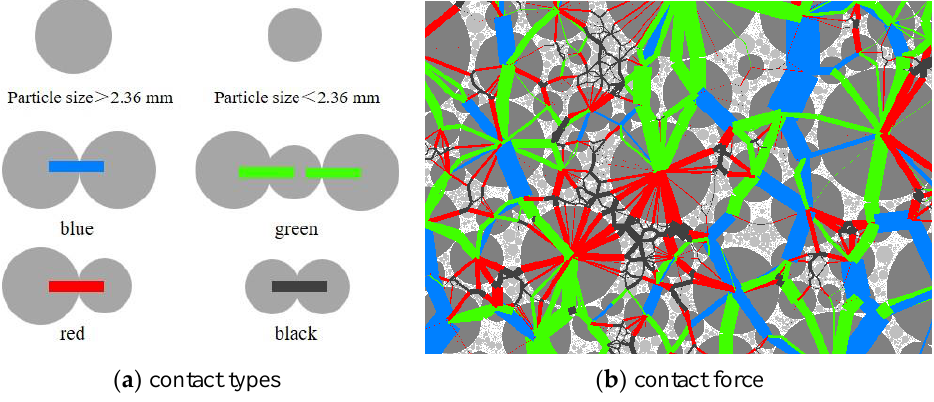
Figure 3. Distribution of contact force. Table 6. The contact force of four contact types.